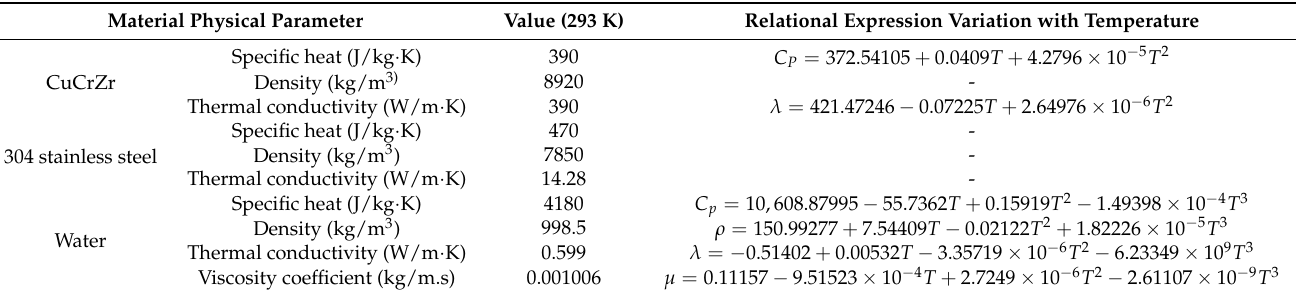
Figure 2. Schematic diagrams of cooling tubes with swirl tape inserted. Table 1. Material physical